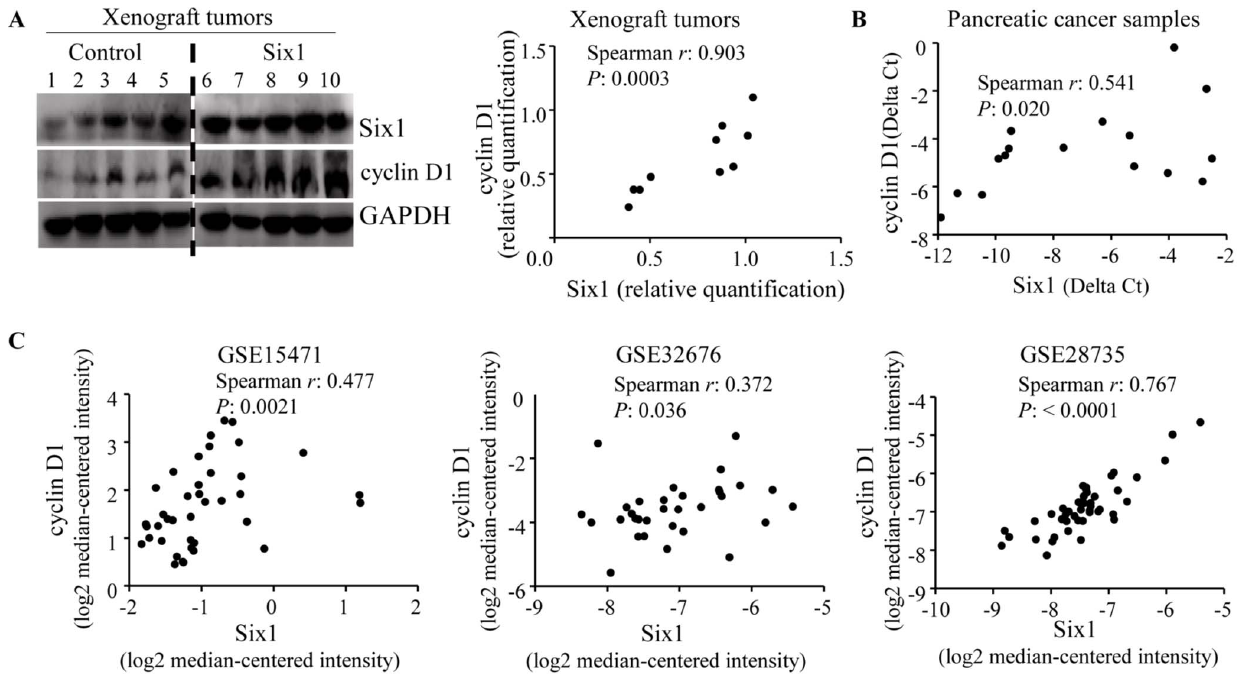
Figure 4. Six1 correlates with cyclin D1 in human pancreatic cancer. A, Six1 levels correlate with cyclin D1 in the xenograft tumors from PANC-1 cells stably transfected with either Six1 or control plasmids as determined by western blot and then quantified by Fluorchem computer analysis (r=0.903, P =0.0003). B, the correlation between the two in 27 advanced stage (III & IV) of human pancreatic cancer samples as determined by qRT-PCR (r=0.541, P =0.020). C, the correlation between the two in three other independent pancreatic cancer microarray datasets (GSE15471: r: 0.477, P : 0.0021; GSE32676: r: 0.372, P : 0.036; and GSE28735: r: 0.767, P , 0.0001). Correlation between the two was quantified by Spearman’s rank correlation. * P ,